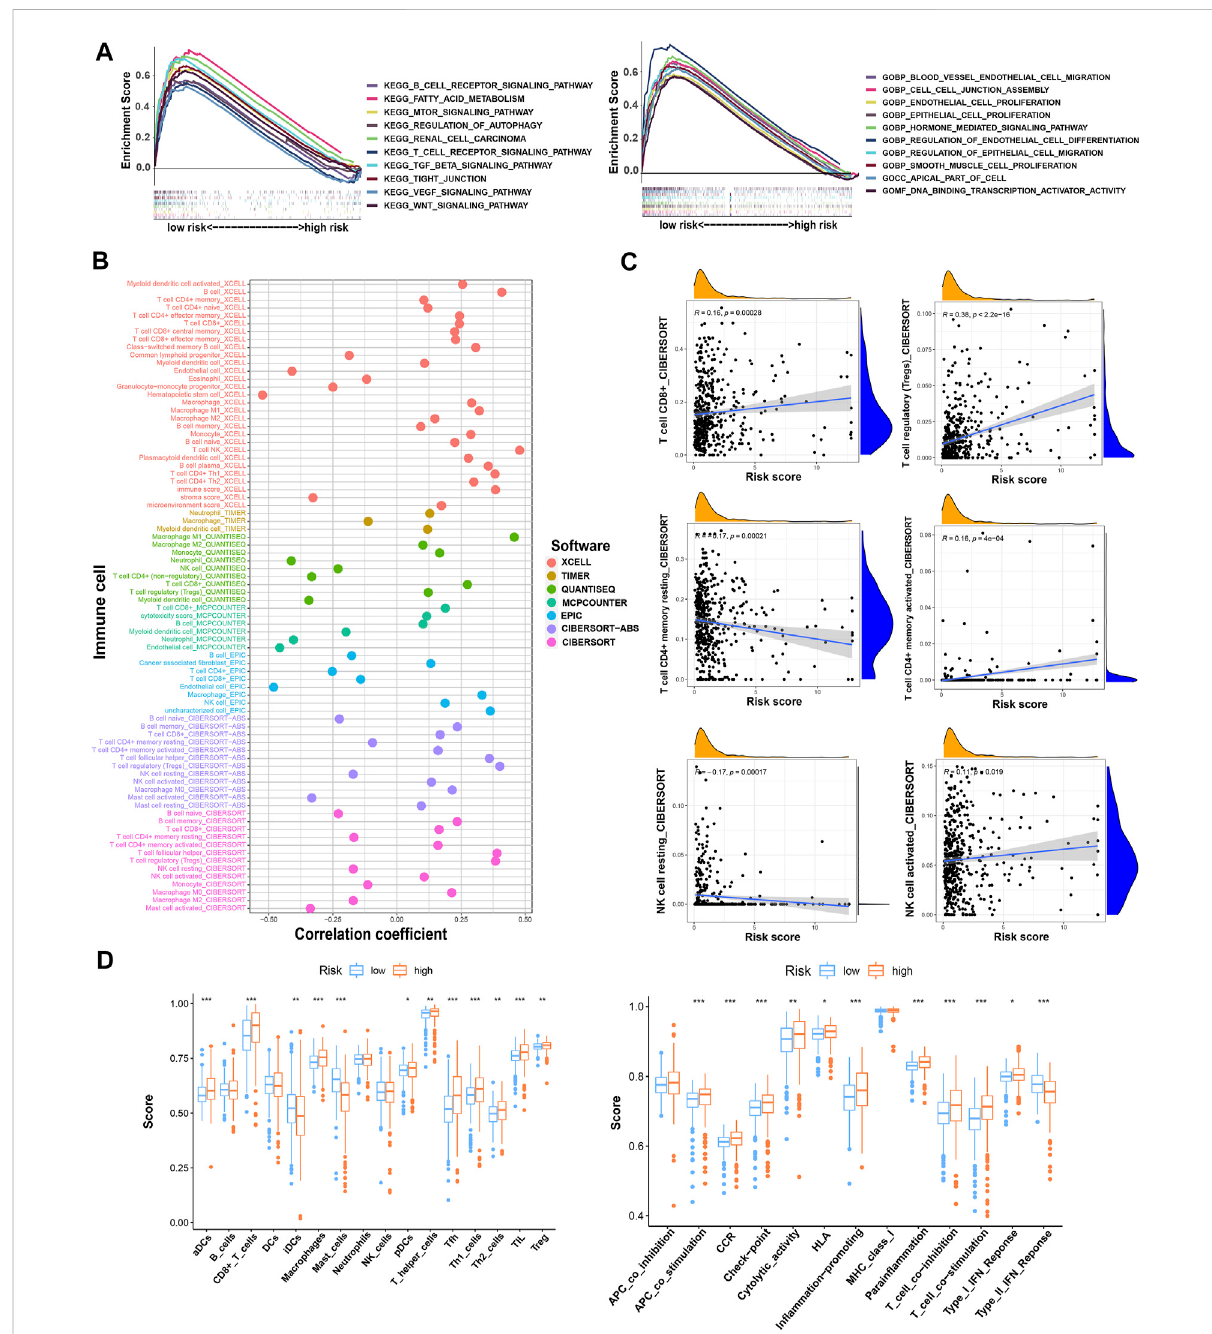
FIGURE 6 Theinvestigationoffunctionandpathwayenrichmentandtumorimmunemicroenvironmentbetweenthehigh-andlow-riskgroups. (A) GSEA of the top 10 functions and pathways signi fi cantly enriched in the low-risk group; (B) the immune cell bubble of risk groups; (C) the correlation between risk score and some of the tumor immune cells; (D) the comparison of ssGSEA score including immune cell score and immune-related function score between risk groups. * means p < 0.05; ** means p < 0.01; *** means p <